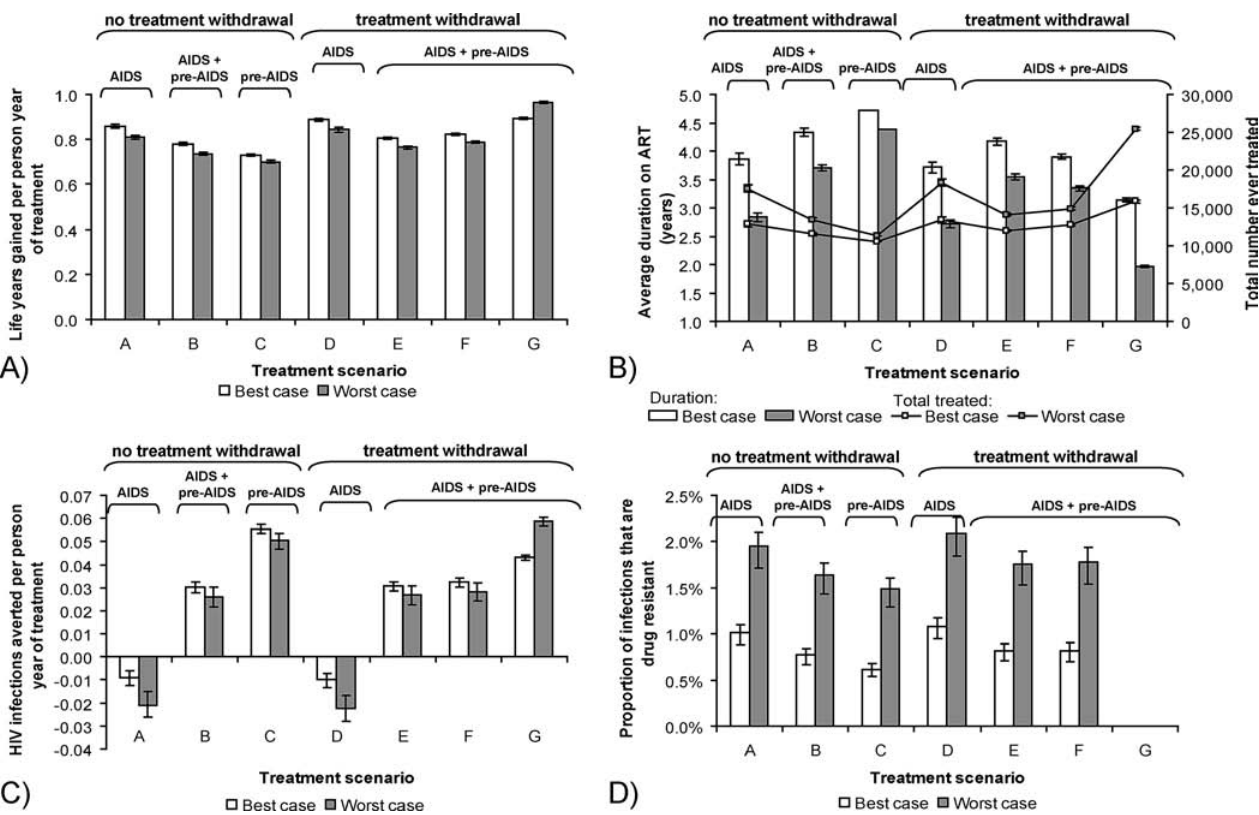
Figure 5. Description of Potential Treatment Strategies for ART Programmes in Resource-Limited Settings Types of ART programme may vary by availability of laboratory tests (CD4 count and viral load testing) and approach to rationing (preferentially treating those at different stages of infection and possibly withdrawing failing treatment). Different strategies are simulated by varying which populations qualify for treatment, and withdrawal of therapy after viral rebound, immunologic, or clinical treatment failure. Outcome measures are ten years after introduction of ART compared with no treatment. The seven scenarios, labelled A–G on the x -axes of the bar graphs, refer to different levels of use of laboratory testing and prioritisation of different groups of patients (see Table 4). Best and worst cases refer to optimistic and pessimistic assumptions regarding ART (see Table 1). Shown are cumulative life-years gained per person-year of treatment compared to no treatment (A); average duration on ART per patient and cumulative number ever treated (B); HIV infections and deaths (all causes) averted per person-year of treatment compared to no treatment (C); and proportion of all infections in the population that are ART-resistant at ten years after ART introduction (D). Results are the median values of the LHS sensitivity analysis; error bars represent the interquartile range. DOI: 10.1371/journal.pmed.0030124.g005